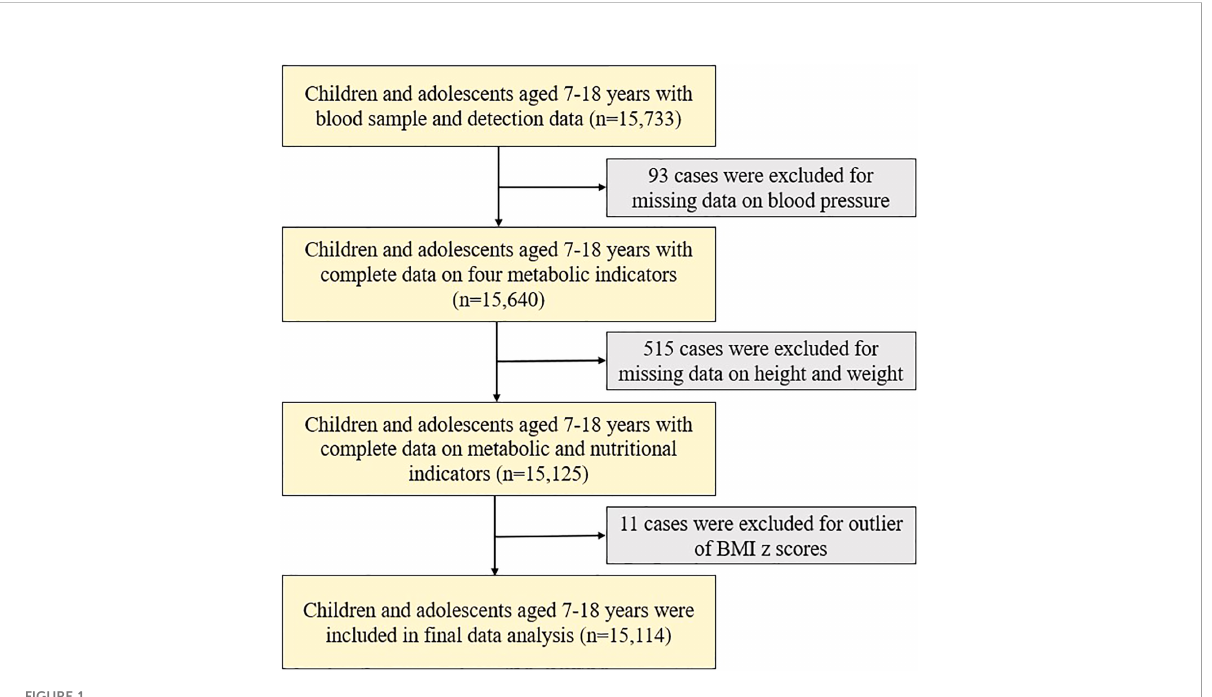
FIGURE 1 Flow chart of data. BMI, Body Mass